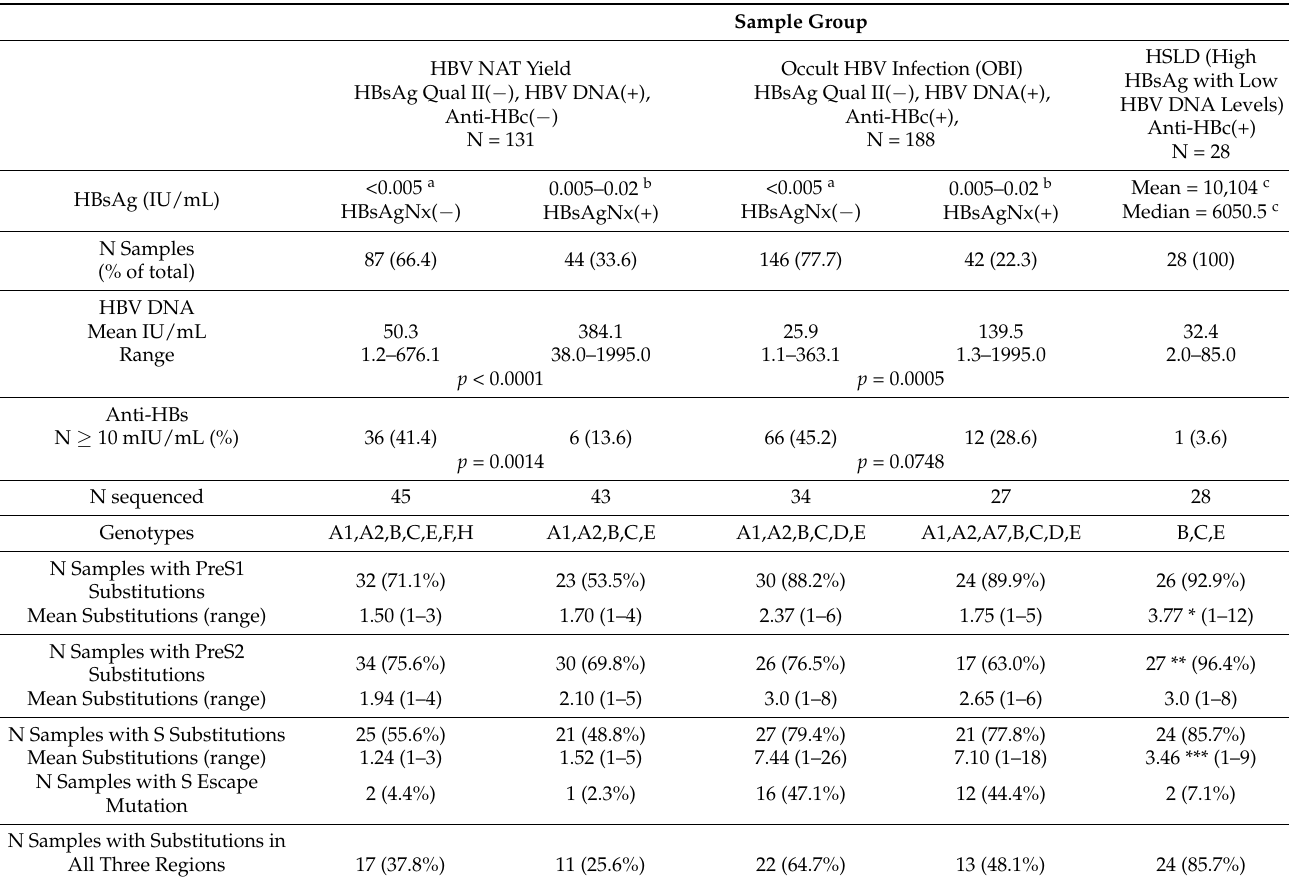
Table 1. Features of Sample Groups Evaluated in this Study (Total of 347